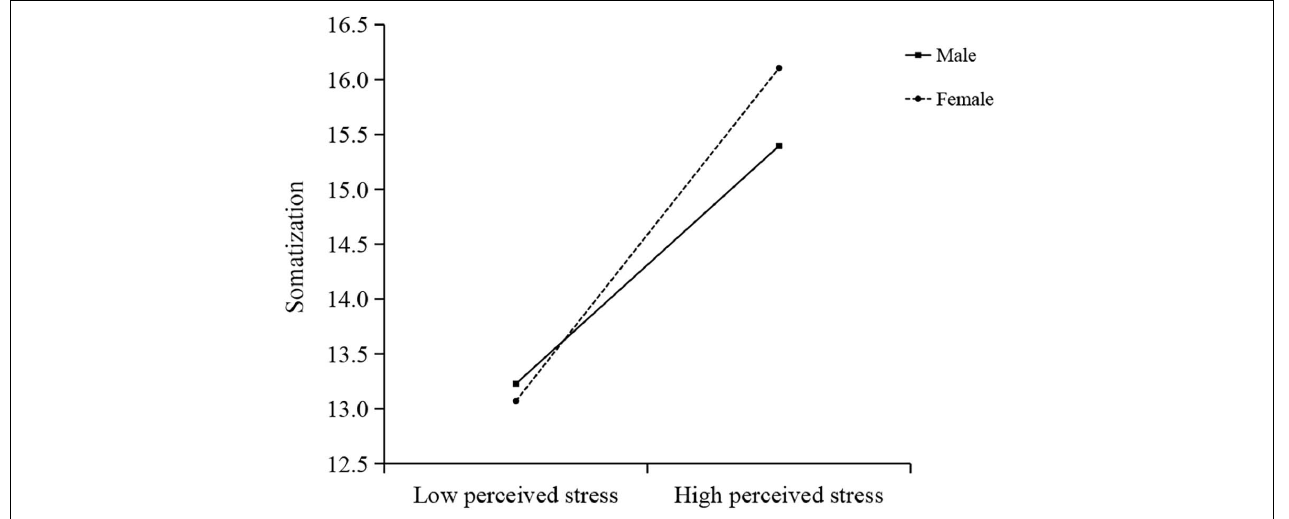
FIGURE 2 | Simple slope analysis showed that sex moderated the relationship between perceived stress and